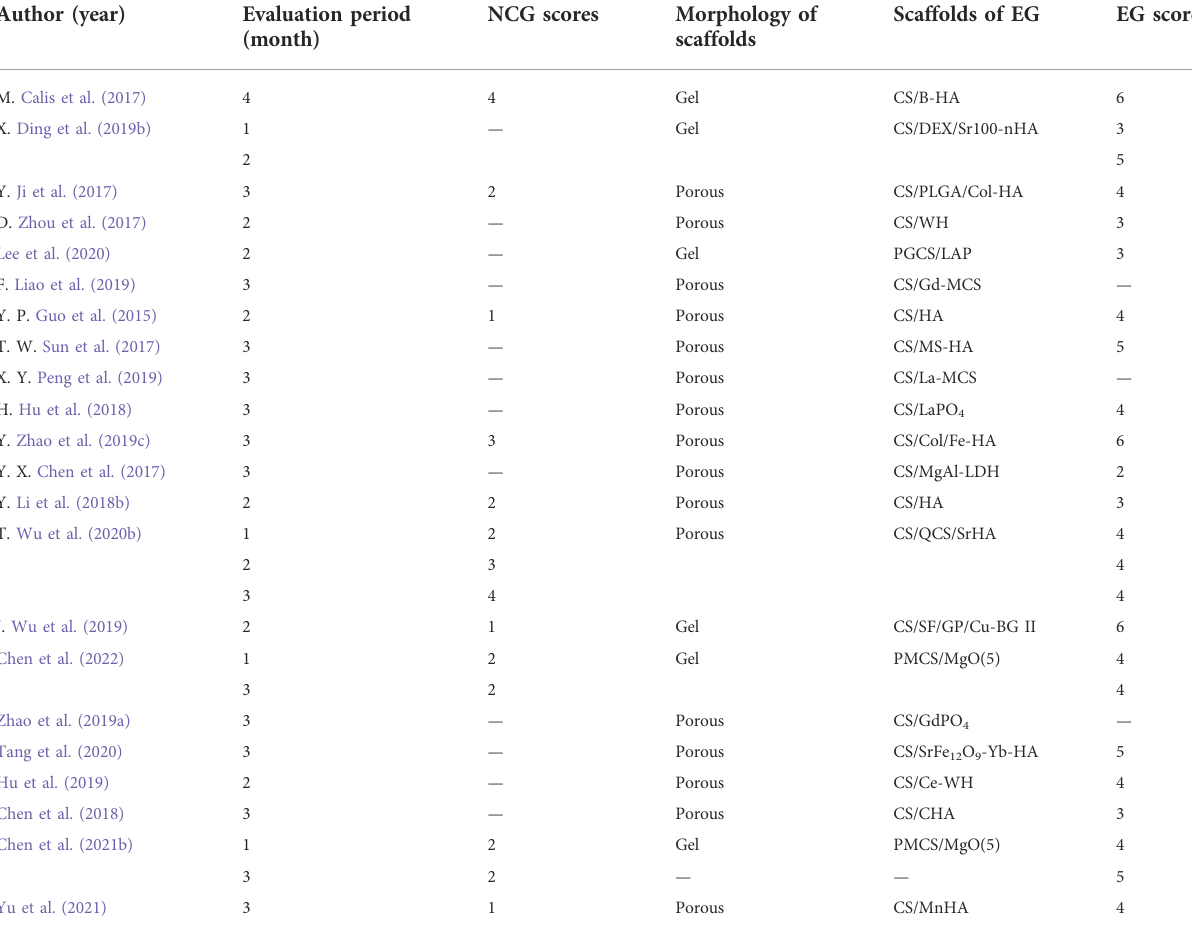
TABLE 7 Semi-quantitative analysis of images derived from the 3D reconstruction of